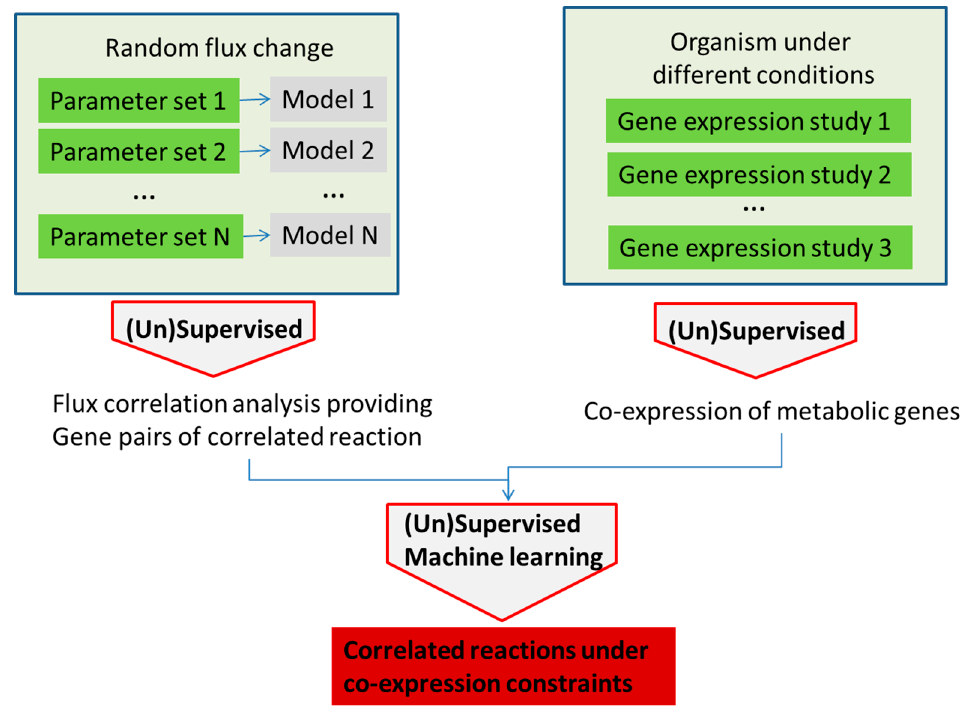
Figure 5. Analysis of gene correlation in stoichiometric models and experimental gene expression data can provide information about the system robustness and lead to more detailed information about gene correlation under different conditions.